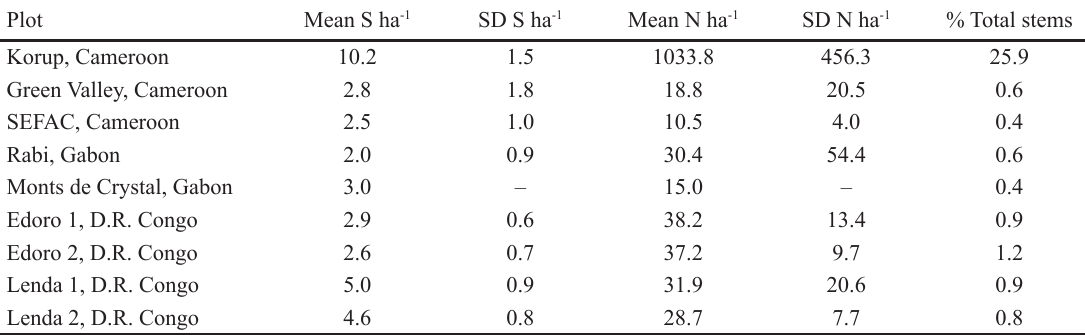
Table 1 – Comparison of Cola species richness among forest plots in Africa where all freestanding trees down to 2 cm have been enumerated. Korup = 50-ha plot in lowland seasonal wet forest in the Korup National Park, Cameroon; Green Valley = six noncontiguous 1-ha plots in the Green Valley logging concession in Semi deciduous forest south of Yokadouma, SE Cameroon; SEFAC (Société d’Exploitation Forestière et Agricole du Cameroun) = four 1-ha plots in the SEFAC logging concession in semi-deciduous forest in SE Yokadouma, also in SE Cameroon; Monts de Crystal = 1-ha plot in the seasonally wet forest in the Monts de Crystal, NW Gabon, Rabi = Rabi 25-ha plot, Gabon; Edoro1 and Edoro2 = 10-ha plots in mixed forest in the Ituri Forest Reserve, D.R. Congo; Lenda1 and Lenda2 = 10-ha plots in monodominant forest also in the Ituri Forest Reserve, D.R. Congo. N= total number of individuals, S = total number of Cola species in a 1-ha sample, and SD is the standard deviation of the 1-ha Plot Mean S ha -1 SD S ha -1 Mean N ha -1